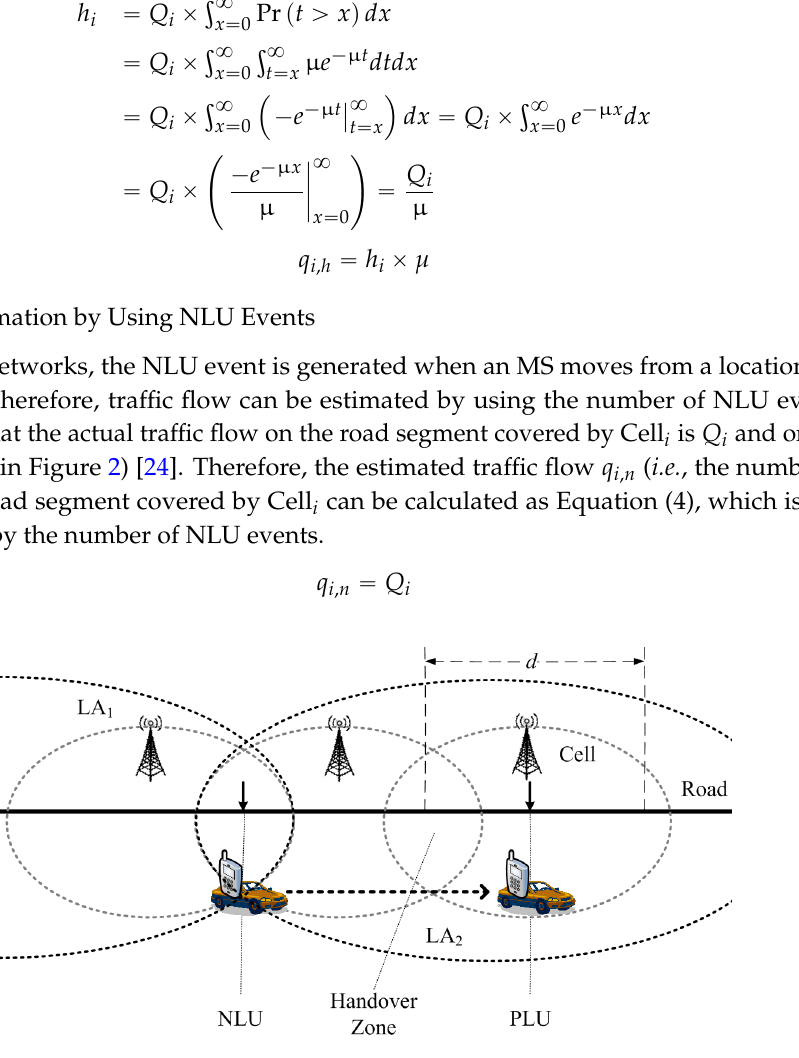
Figure 2. The scenario diagram of location update events. LA, location area.